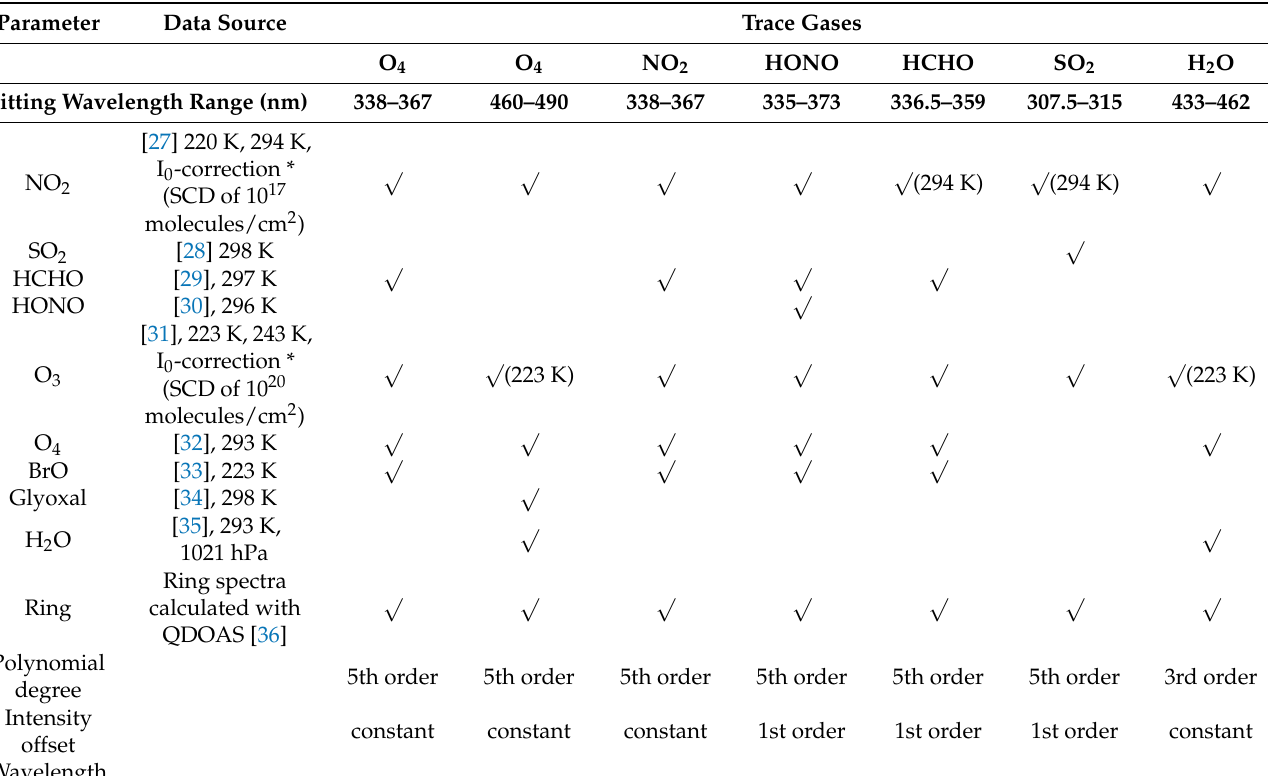
Table 1. Summary of retrieval settings for the O 4 , NO 2 , HONO, HCHO, SO 2 , and H 2 O DOAS spectral analyses. Parameter Fitting Wavelength Range